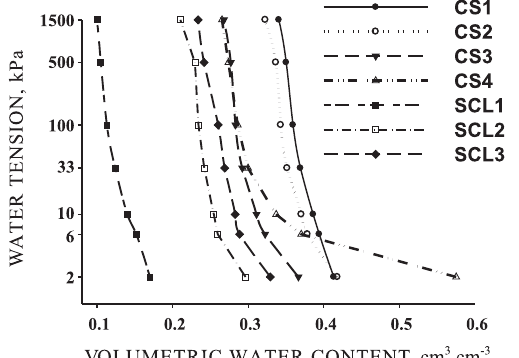
Figure 1. Soil water retention curves for soils